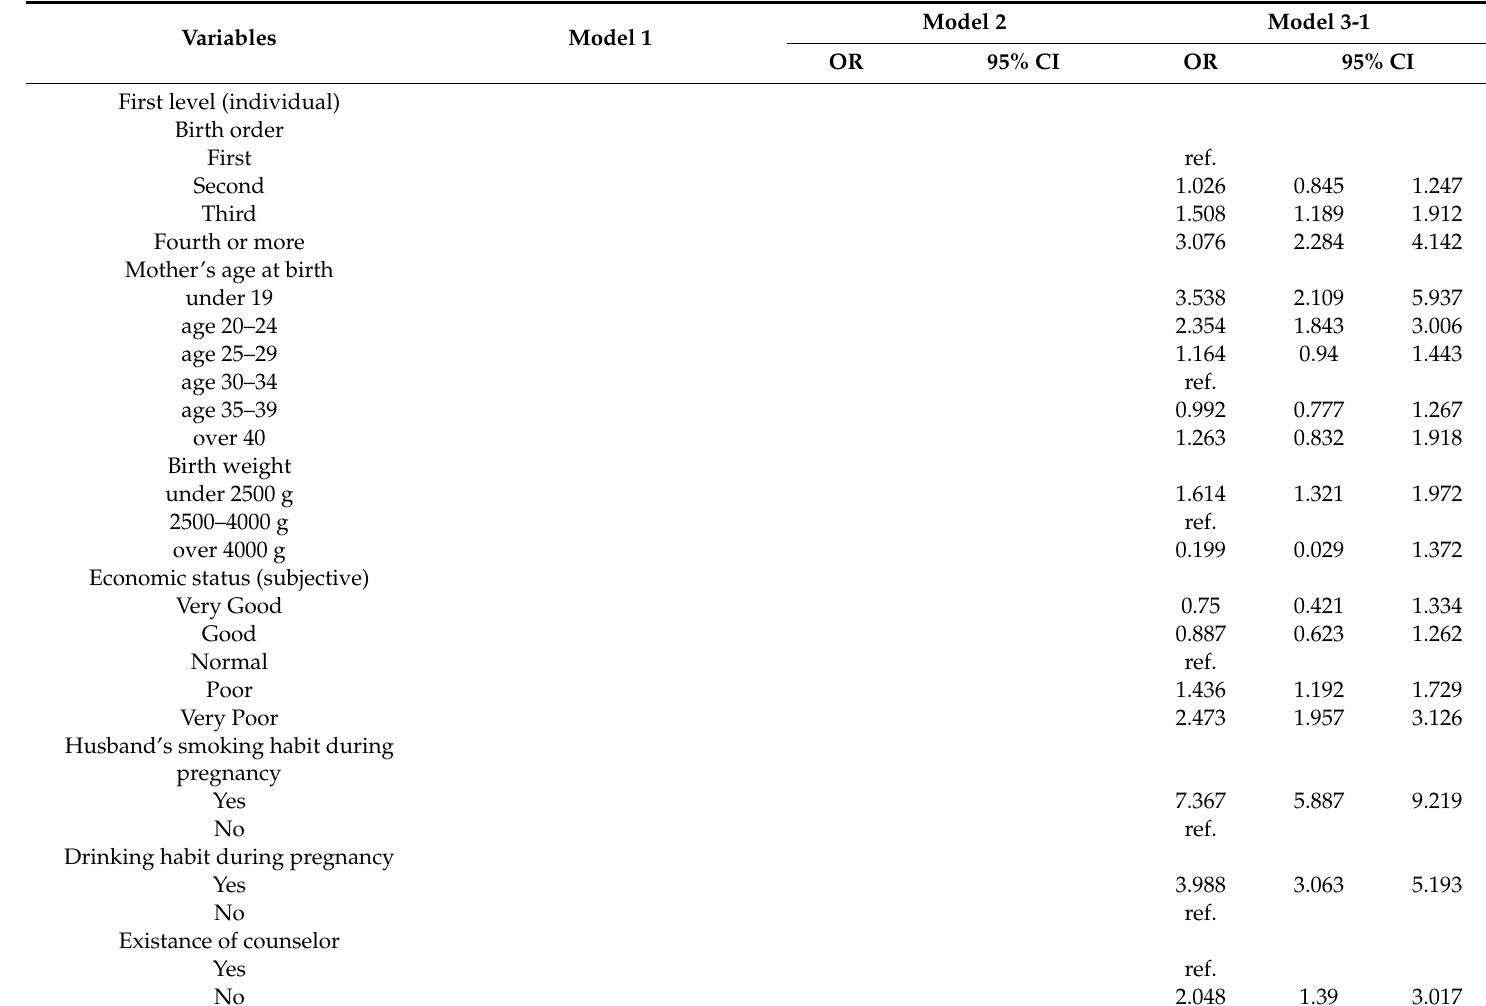
Table A1. Multilevel logistic regression with stepwise (Model 1–Model